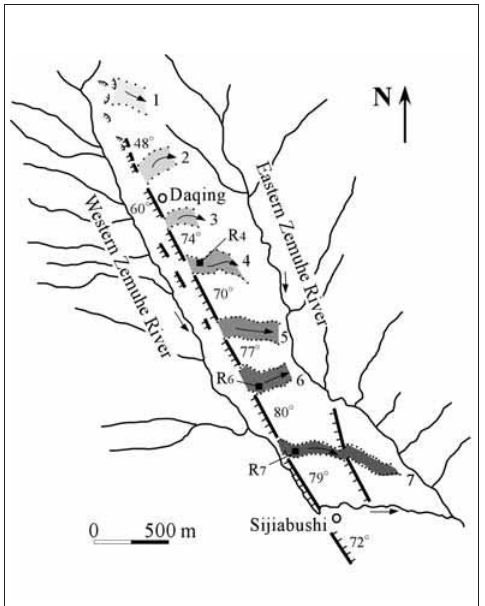
Fig. 5. Map of the fault scarp, offset ravines and drai- nage system on the top of the Daqingliangzi uplift. Thick line is the fault scarp with ticks on the downth- rown side of the fault. Thin lines show the drainage system. Gray zones show the ravines; the grayscale from dark to light show the age of ravines from young to older. Arrows in the gray zones indicate the follo- wing directions. Black squares indicate the locations of the C 14 samples.